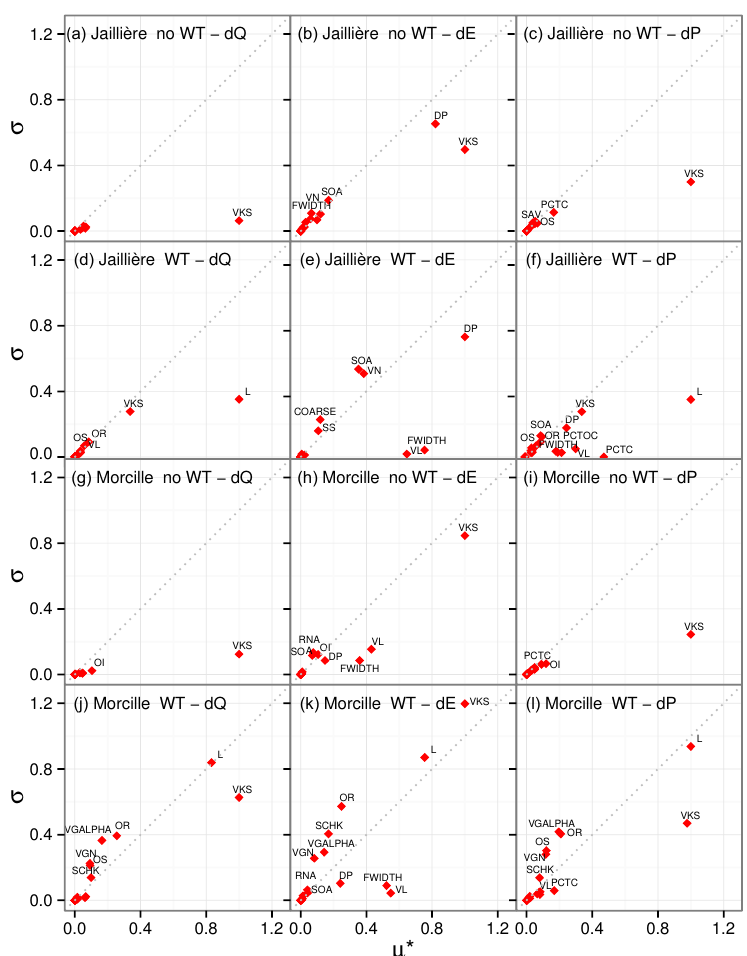
Figure 6. Morris elementary effects results for d Q (reduction of surface water), d E (reduction of sediment), and d P (reduction of pesticide isoproturon) on Jaillière (a–f) and Morcille (g–l) sites, without water table (no WT) and with water table (WT) present. Factors with negligible effects (close to the origin) are not